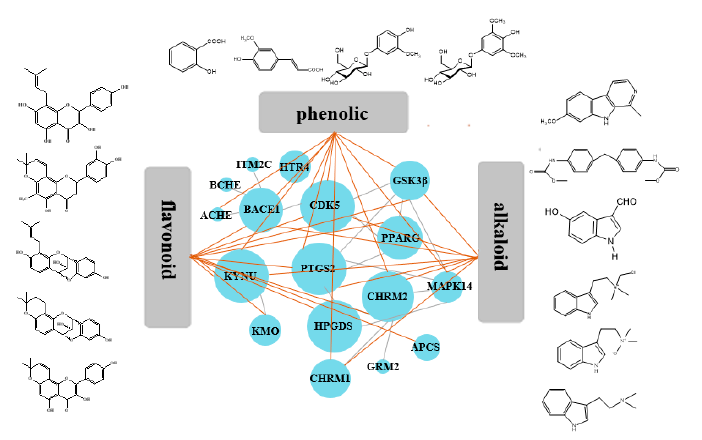
Figure 3. Analyses of compound–target–target (C–T–T) interaction. The 3 gray areas represent compound types and 16 blue circles represent the targets of OC.